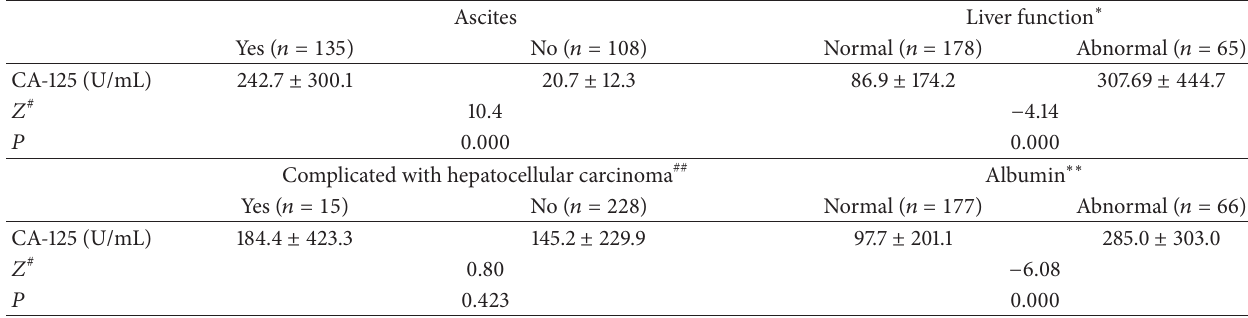
Table 3: Serum CA-125 level differed in patients with Budd-Chiari syndrome (mean ±